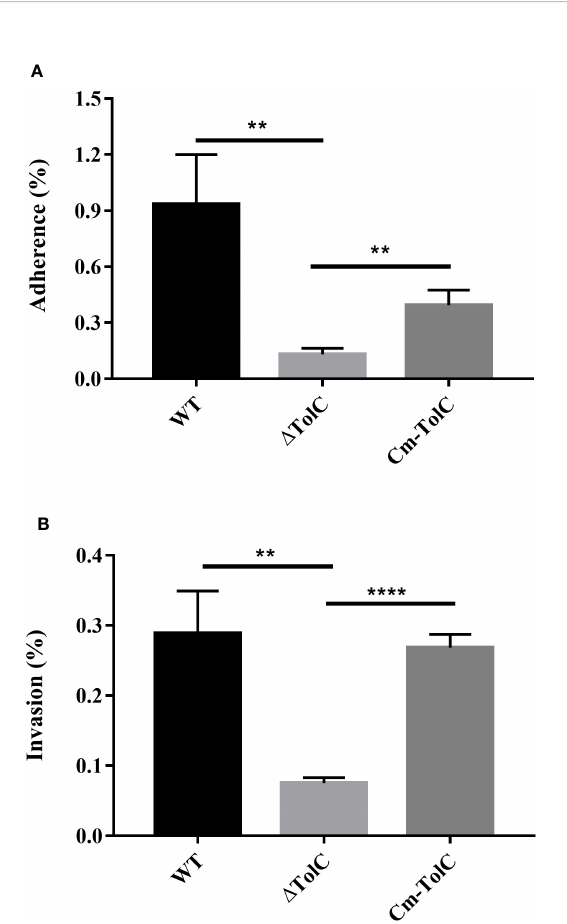
FIGURE 5 Adherence (A) to and invasion (B) into PAVECs by WT, D TolC, and Cm-TolC strains. The results are expressed as the means of recovered bacteria per milliliter. Statistical analyses were performed using a two unpaired t-test. Statistically signi fi cant difference is indicated as ** p ≤ 0.01 and **** p ≤ 0.0001.